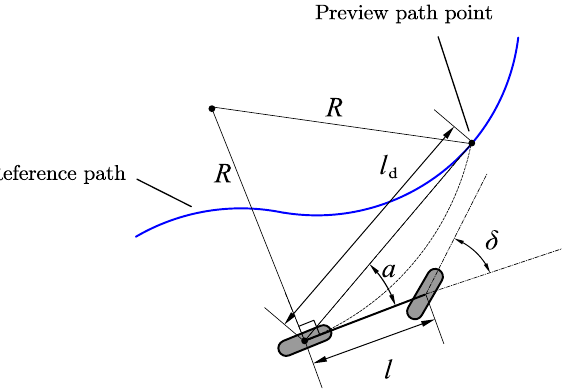
Figure 1. Geometric analysis of pure pursuit method.